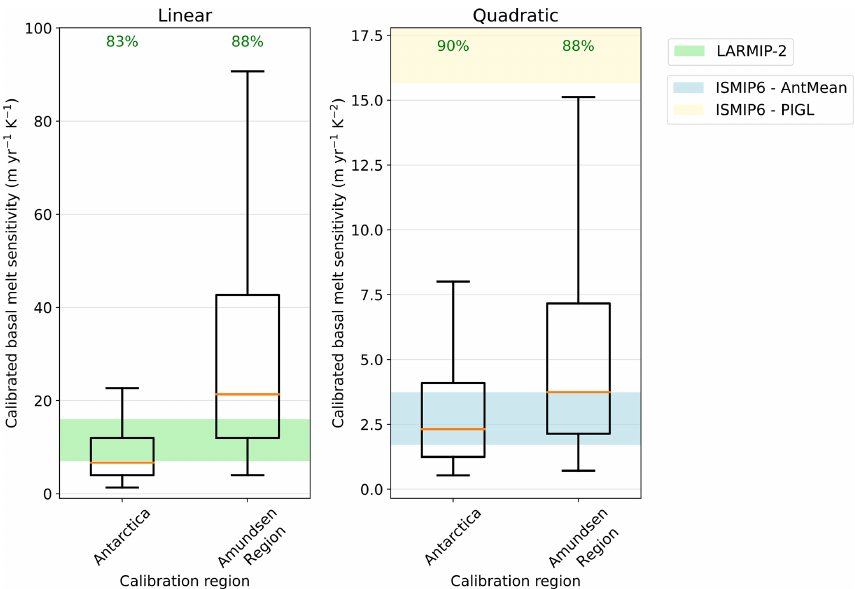
Figure 5. Box and whisker plots of basal melt sensitivity values corresponding with the calibrated γ values of ESM-RF pairs. Only the sensitivities of calibrated γ values greater than zero are shown in the plots. The percentage of ESM-RF pairs with positive γ values is indicated by the green values on top of the boxes for each region. The horizontal orange line indicates the median value, boxes indicate the 25–75 percentile range and whiskers the 5–95 percentile range. Values beyond this range are not shown. The shaded regions indicate basal melt sensitivity ranges that are used in other studies. The green shading represents the basal melt sensitivity range of 7–16myr − 1 K − 1 used in Levermann et al. (2020). The blue and yellow shading indicate the 5%–95% range of the basal melt sensitivities corresponding with the γ values used for the nonlocal quadratic parameterisation in ISMIP6 (Jourdain et al., 2020) for both the Antarctic mean (AntMean) and Pine Island’s grounding line (PIGL) calibration option, respectively. For PIGL the 95% bound is 84myr − 1 K − 2 , which is outside the scale of the vertical